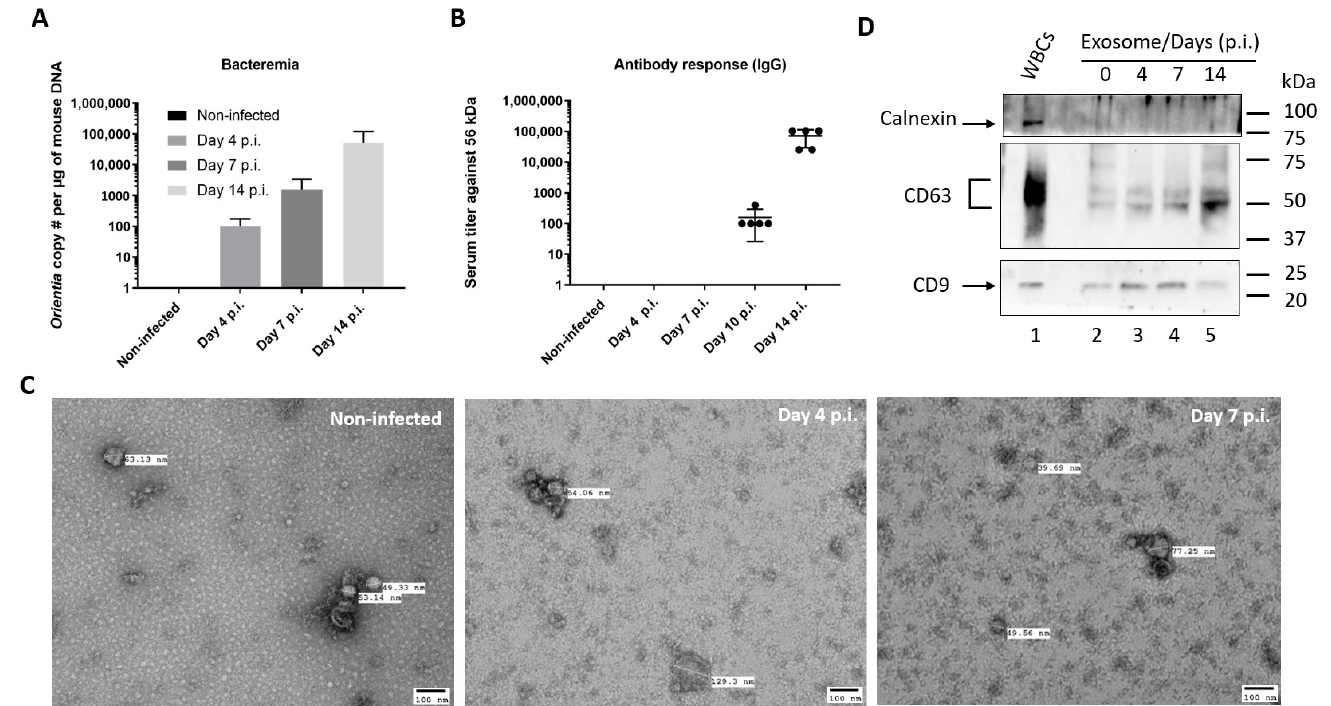
Figure 1. Serum exosomes isolated from O. tsutsugamushi -infected CD-1 mice. ( A ) Blood DNA was extracted from non- infected and infected mice ( n = 3 per group) and amount of Orientia was determined by quantitative PCR. The experiment was repeated twice and representative data were shown. Error bar, standard deviation. ( B ) IgG antibody titers against Orientia major surface antigen, 56 kDa protein, was determined by ELISA using four-fold serially-diluted mouse serum ( n = 5 per time point). Error bar, standard deviation. ( C ) Representative electron microscope images of exosomes isolated from serum of non-infected mice or Orientia -infected mice 4 days and 7 days after infection. ( D ) Exosomes and white blood cells (WBCs) were lysed and analyzed by Western blot for the presence of Calnexin, CD9 and CD63 proteins. Lane 1, WBC lysate from CD-1 mice; Lane 2-5, lysate of 20 µL serum exosomes from non-infected or infected mice of day 4, 7 and 14 post infection (p.i.).